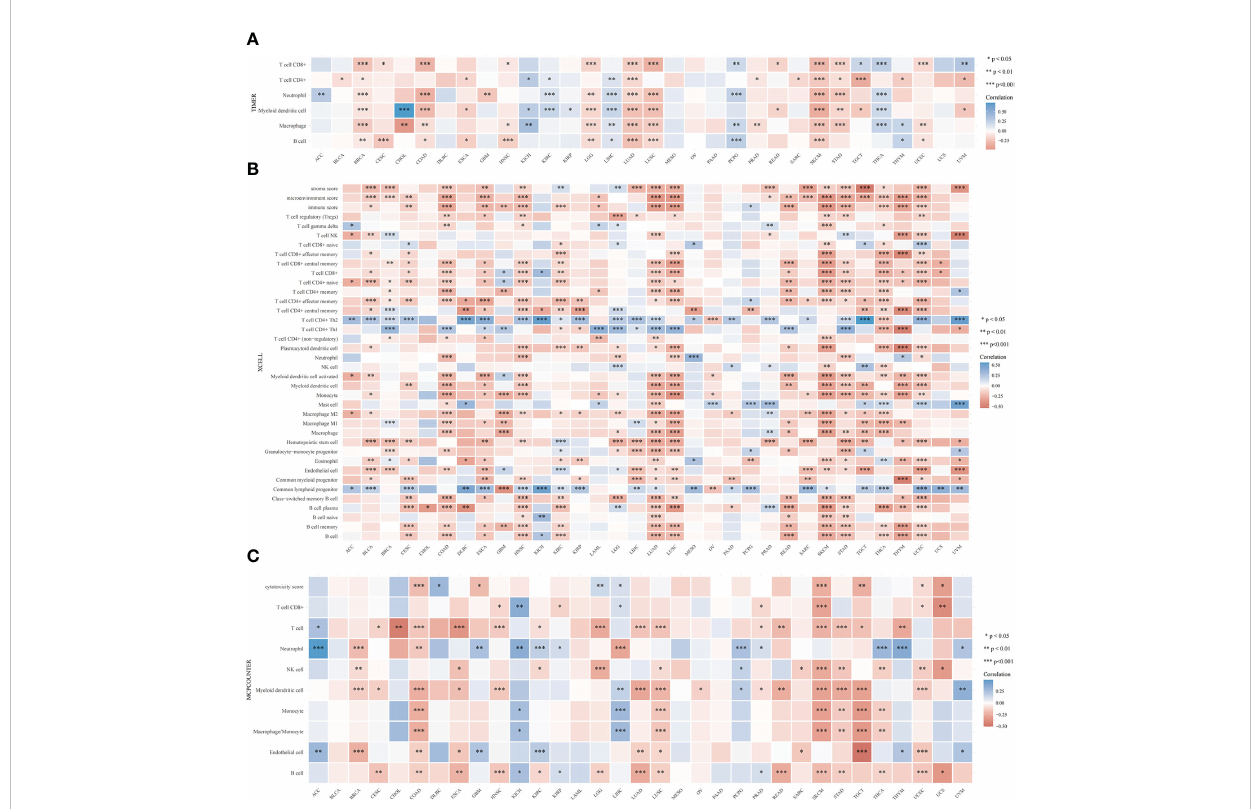
FIGURE 12 Pan-cancer analysis of the correlation between RRS1 expression and immune cell in fi ltration. (A) Correlation between RRS1 expression and the in fi ltration levels of various immune cells based on TIMER. (B) Correlation between RRS1 expression and in fi ltration levels of various immune cells based on xCELLs. (C) Correlation between RRS1 expression and in fi ltration levels of various immune cells based on